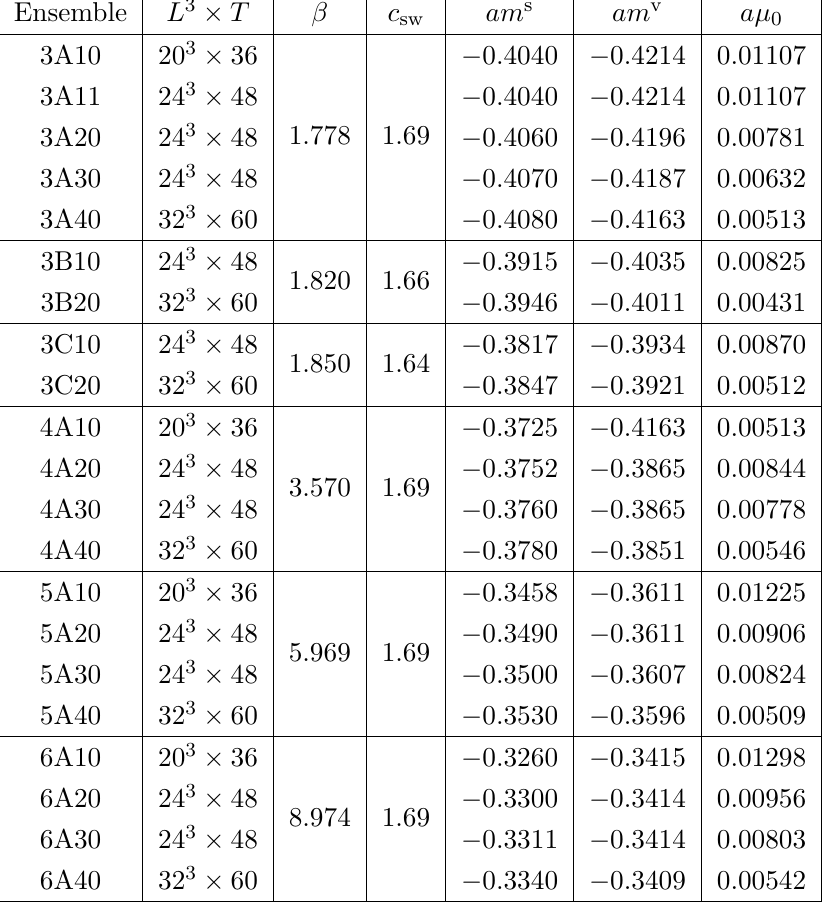
Table 1 . Summary of ensembles used in this work. L and T indicate the number of points in the spatial and temporal extent, respectively. β is the gauge coupling, c coefficient, and am s is the bare mass of the Dirac operator in the sea sector. Finally, am v and aµ are the parameters for the mixed-action setup — the bare mass and the bare twisted mass, in this same